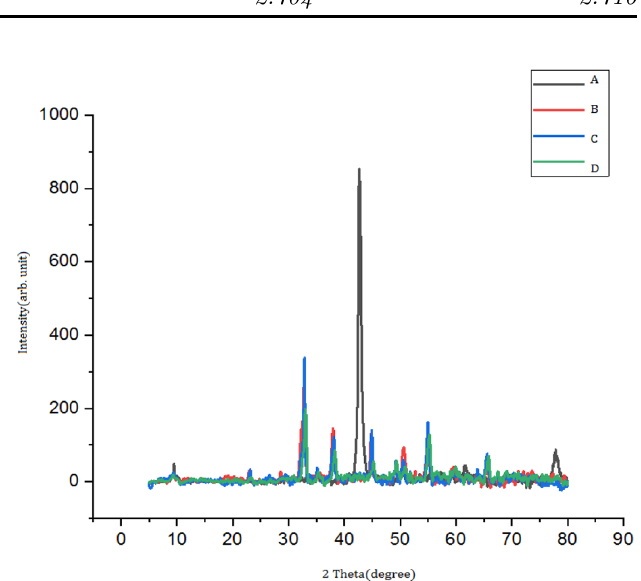
Fig. 2. XRD patterns of alloys Ni 49 Fe 1 Mn 30 Sn 18 In 2 , Ni 48 Fe 2 Mn 30 Sn 16 In 4 , Ni 47 Fe 3 Mn 30 Sn 14 In 6 and Ni 46 Fe 4 Mn 30 Sn 12 In 8 represented as A, B, C and D respectively.